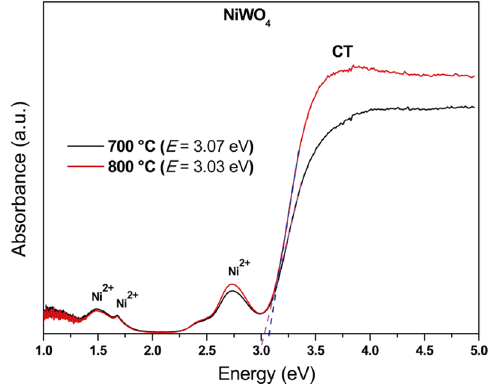
Fig. 7 Raman spectra of the NiWO 4 powders calcined at 700 and 800 ℃ for 2